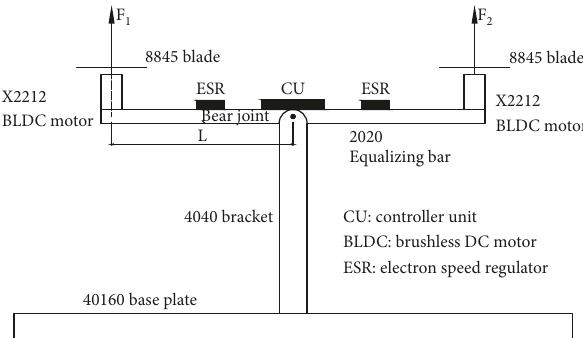
Figure 1: The twin-rotor equalizing